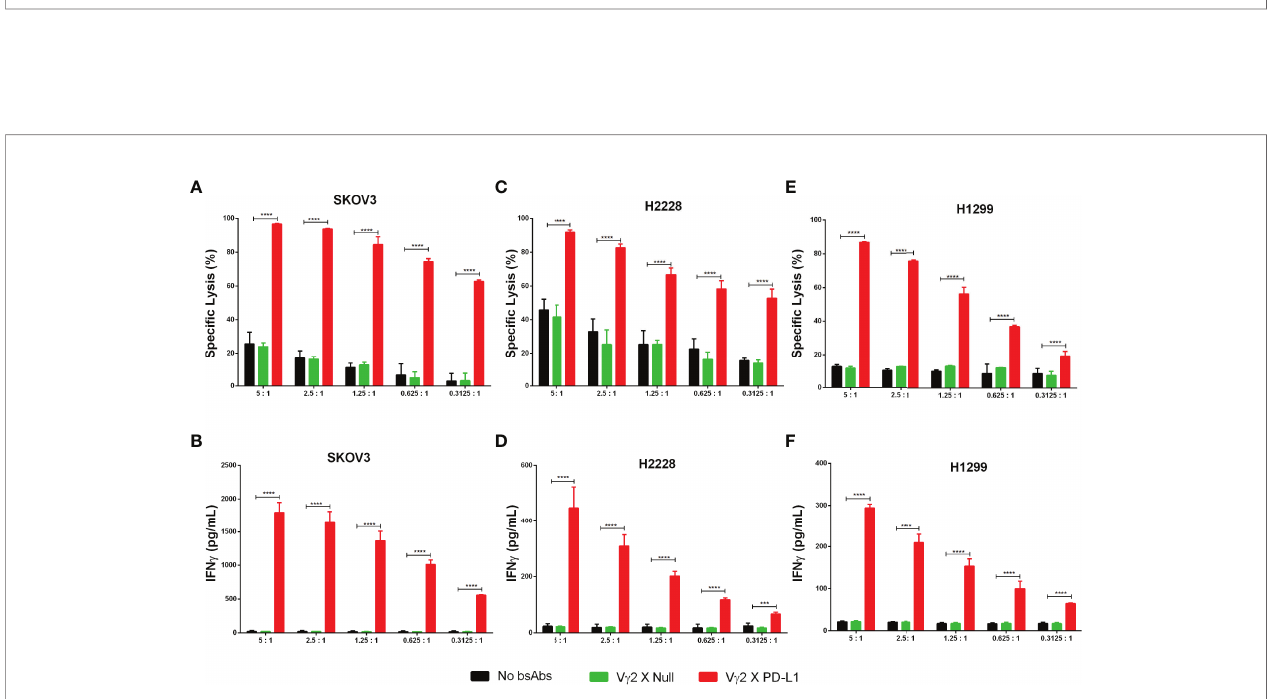
FIGURE 5 | V g 2 X PD-L1 prompts signi fi cantly V g 2V d 2 T cell-mediated PD-L1+ tumor cell killing through releasing IFN g . (A – F) V g 2V d 2 T cells enriched negatively from Zol +IL2 cultures were co-cultured with tumor targets (luciferase-expressing SKOV3, H2228, and H1299 cells) for 12 hours in the presence of 1 ug/mL (8 nM) V g 2 X PD-L1 or V g 2 X Null with serial E:T ratios, ranging from 5:1 to 0.3125:1. The tumor cell killing was measured by recording the RLU of each treated well (A, C, E) , and the releasing amounts of IFN g were determined by ELISA (B, D, F) . Data were presented as Mean±SD pooled from n=4 biological replicates of two independent experiments. **** p <0.0001 (Two- way ANOVA, Dunnett ’ s multiple comparisons test). *** p